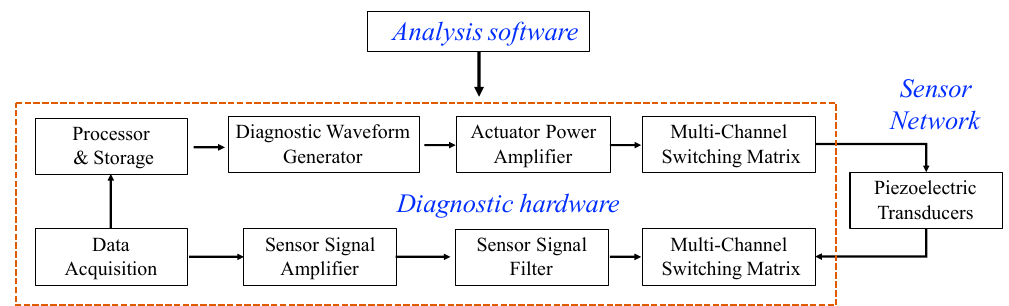
Figure 5. Diagram of the integrated active diagnostic hardware (adapted from [21]).